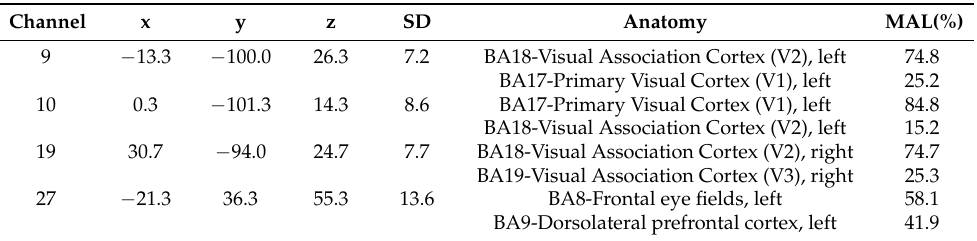
Table 1. The MNI coordinates of channel 9, 10, 19, 27 and the probability of the recorded data originating from the listed anatomical locations.